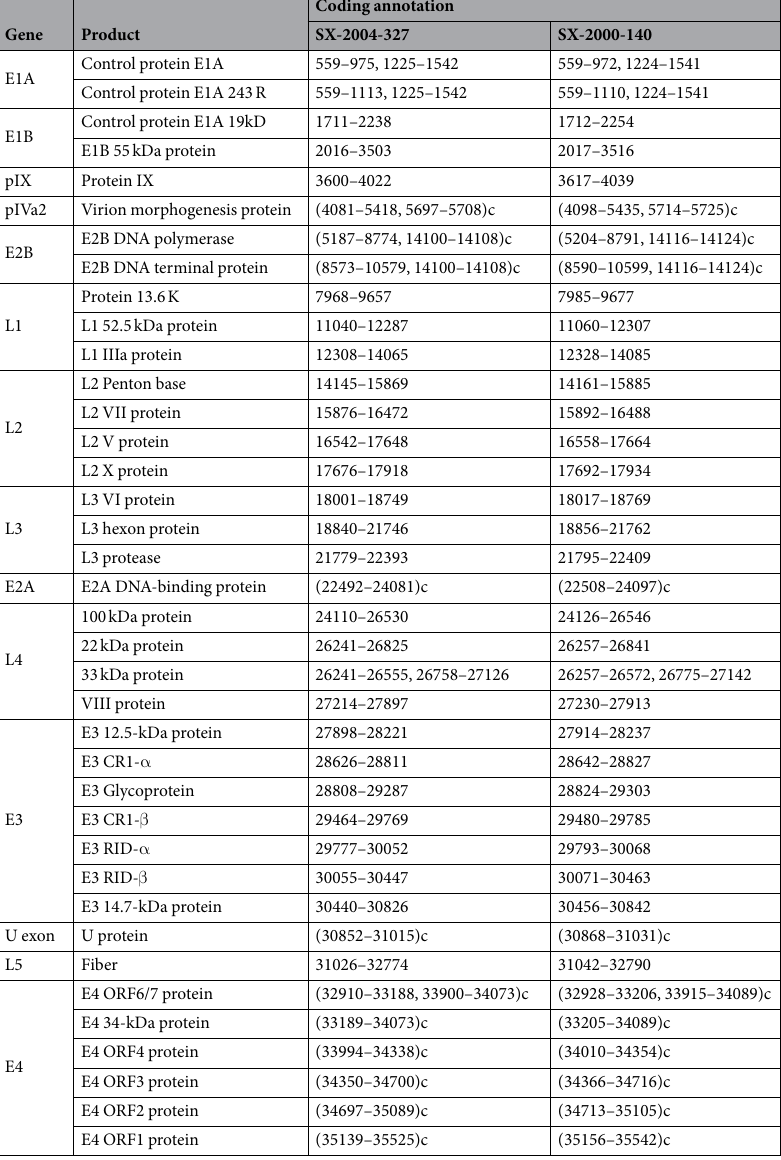
Table 1. Genome coding annotations of strains SX2000-140 and SX2004-327. Note: A total of 38 putative coding regions for both Shanxi HAdV strains were